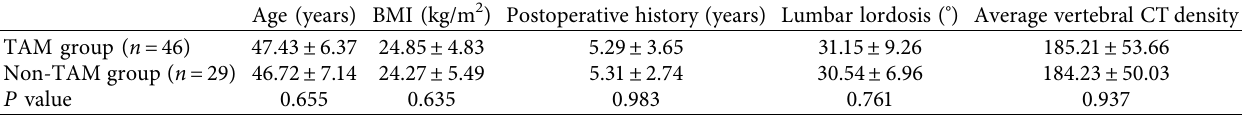
Figure 3: Modic classification for vertebral endplate changes (the patients pictured were not included in the study). (a) Type I: decreased signal on T1- and increased signal on T2-weighted images. (b) Type II: increased signals on both T1- and T2-weighted images. (c) Type III: decreased signals on both T1- and T2-weighted images. Table 2: Comparisons of patient age, BMI, postoperative history, lumbar lordosis, and average vertebral CT density.